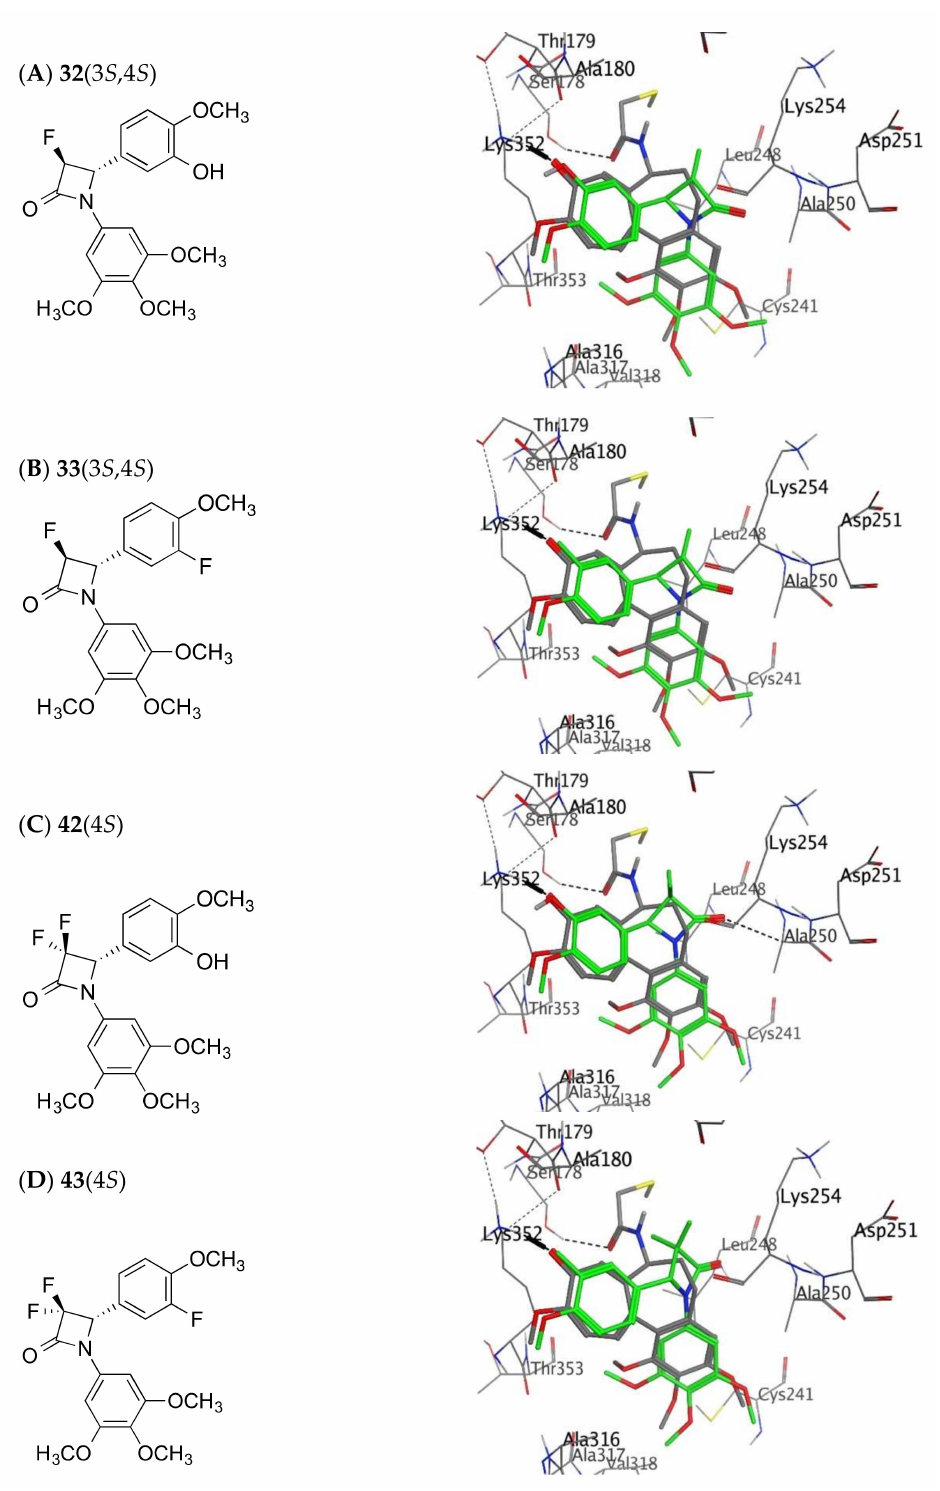
Figure 9. Overlay of the X-ray structure of tubulin co-crystallised with DAMA-colchicine (PDB entry 1SA0) on the best ranked docked poses of the S enantiomers of β -lactams: ( A ) 32 (3 S ,4 S ), ( B ) 33 (3 S ,4 S ), ( C ) 42 (4 S ) and ( D ) 43 (4 S ). Ligands are rendered as tubes and amino acids as lines. Tubulin amino acids and DAMA-colchicine are coloured by atom type, the novel β -lactam compounds are coloured with a green backbone. The atoms are coloured by element type; carbon = grey, hydrogen = white, oxygen = red, nitrogen = blue, sulphur = yellow, fluorine = green. Key amino acid residues are labelled and multiple residues are hidden to enable a clearer